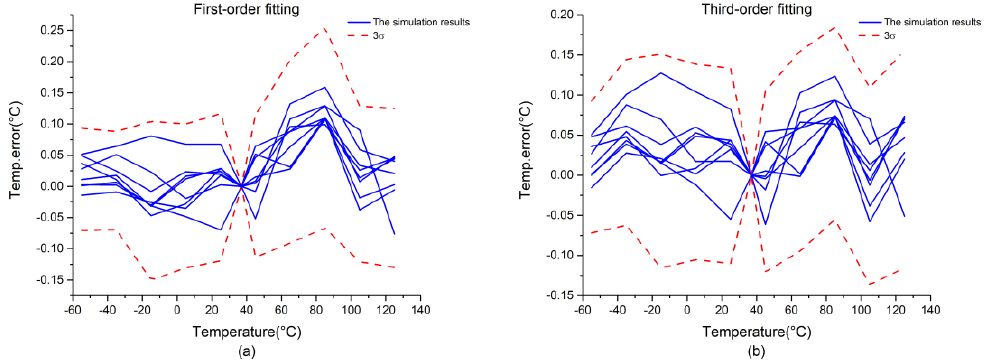
Figure 9. Simulation results for the chip: ( a ) first-order fitting; ( b ) third-order fitting.